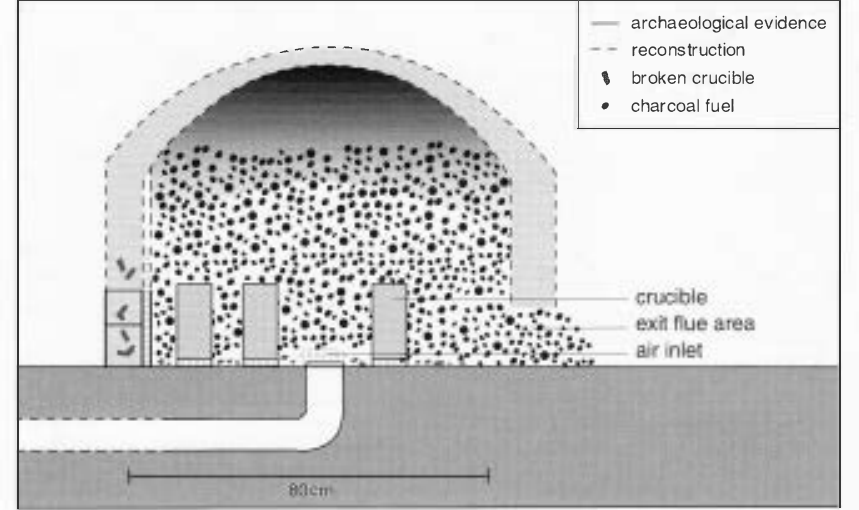
Figure 3 A schematic reconstructed cross section through one of the crucible-steel furnaces found at Gyaur Kala, Merv. One aspect of this adaptation is the effi­ cient use of fuel. As noted above, the cru­ cibles appear to have been placed in the Merv furnaces in an unfired